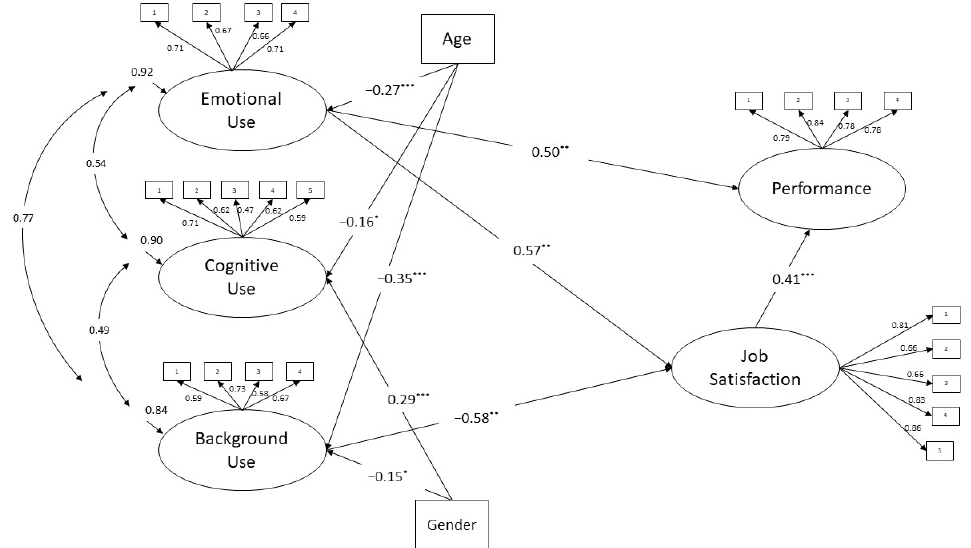
Figure 1. Model (ML estimation; standardized path coefficients; N = 235) controlling for age and gender (1 = Male). Non-significant relationships were not reported in the figure. * p < 0.05; ** p < 0.01. *** p < 0.001 for all factor loadings. Table 4 summarizes the indirect effects. Table 4. Indirect effects of the model.